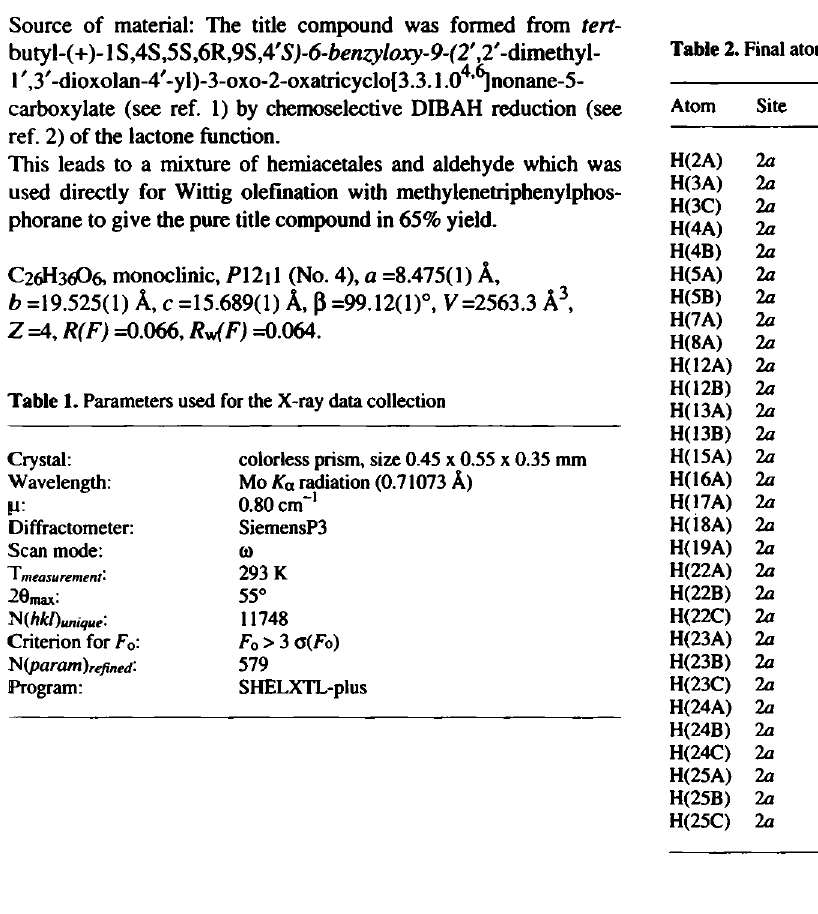
Table 2. Final atomic coordinates and displacement parameters (in Â 2